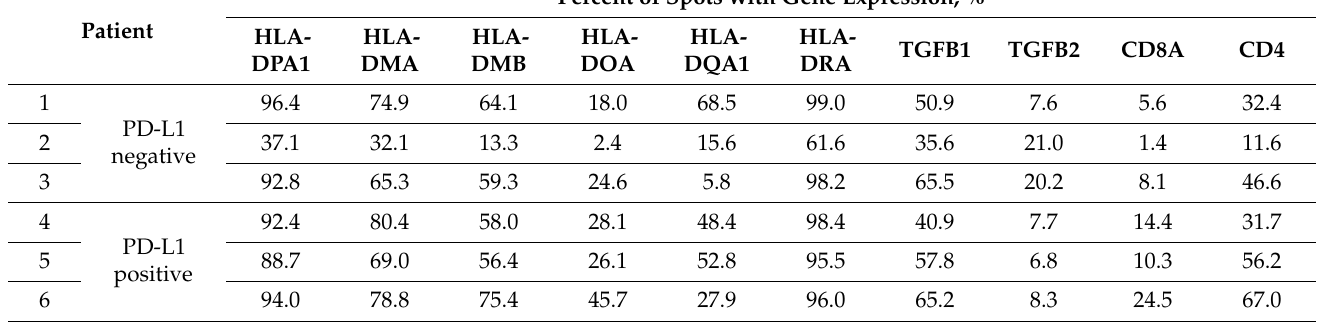
Table 1. HLA gene set, TFGB1 and 2, CD8A, and CD4 expression in spots from PD-L1-negative and PD-L1-positive